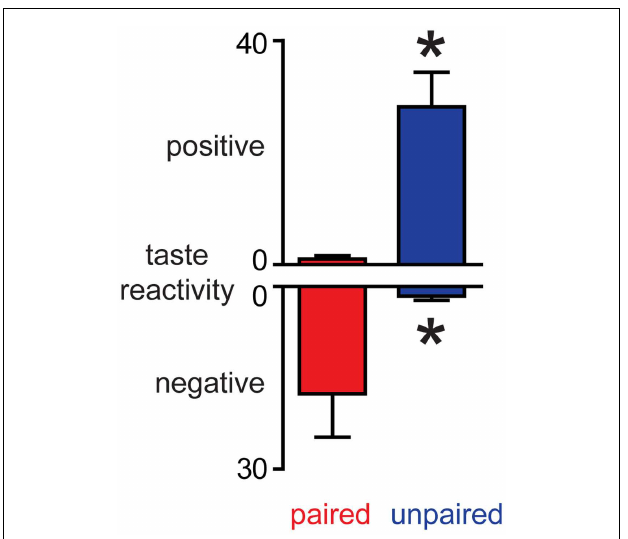
FIGURE 3 | Induction of conditioned taste aversion leads to a decrease in the palatability of sucrose. In Paired rats, sucrose infusions evoke more negative and less positive orofacial movements than in Unpaired rats. * p < 0.05 vs. Paired